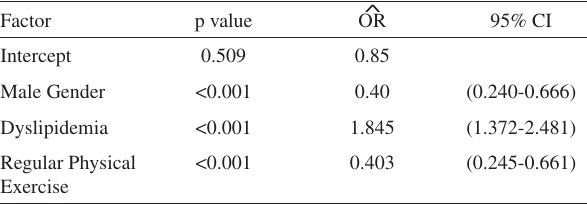
Table 3 - Logistic regression model to explain lower scores in the psycological domain